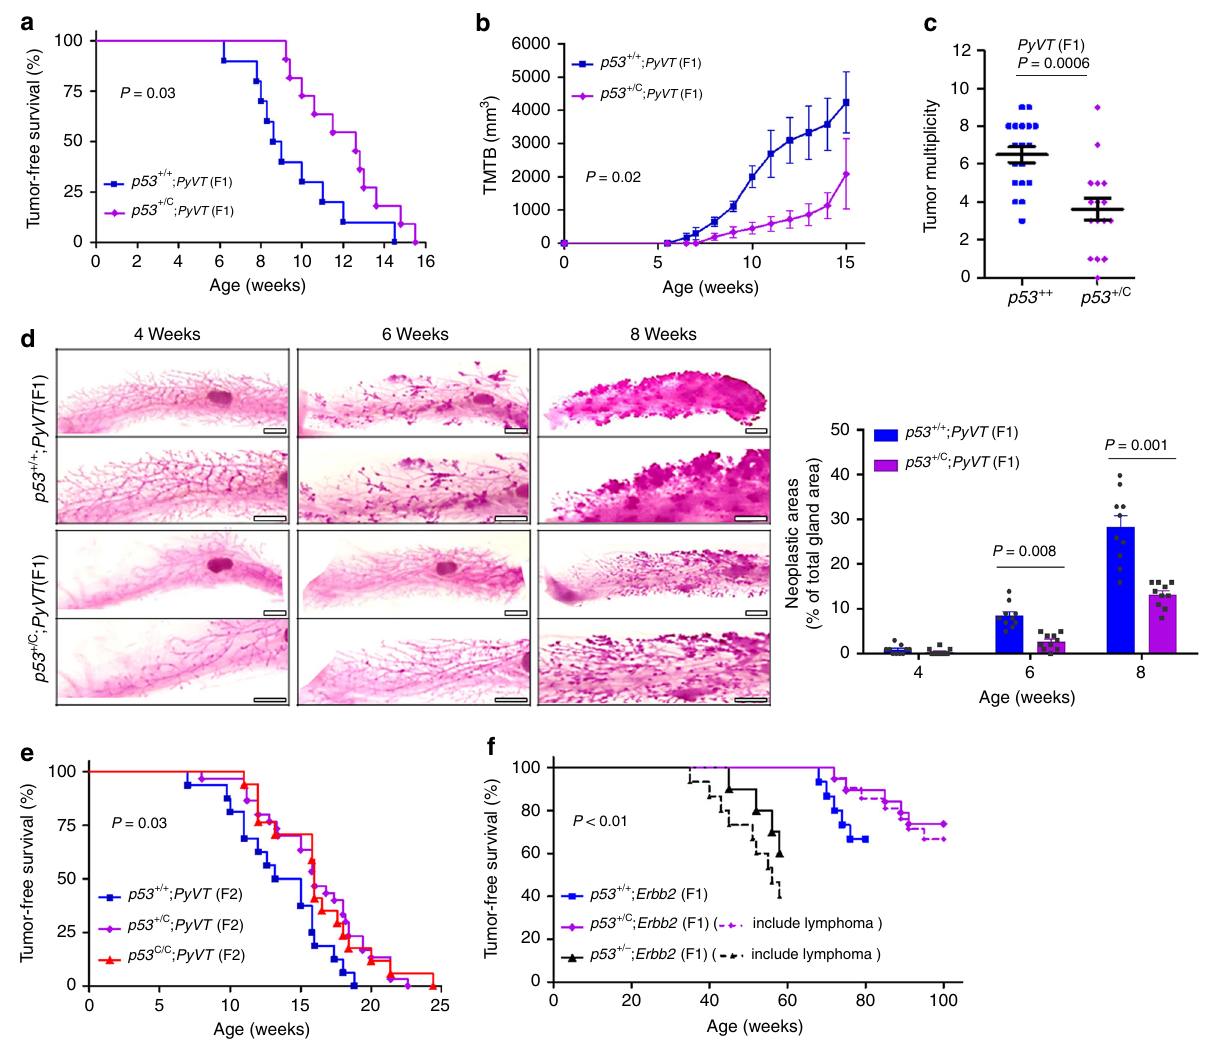
Fig. 2 p53 C delays either PyVT - or Errb2 -driven mammary tumorigenesis in mice. a Tumor-free survival of F1 female offspring of p53 + /C mice crossed with PyVT -overexpressing mice (FVB/N-Tg(MMTV-PyVT)634Mul/J). n = 10 for p53 + / + ; PyVT and n = 11 for p53 + /C ; PyVT ; P = 0.03 (log-rank test). b Tumor volume in F1 female p53 + / + ; PyVT and p53 + /C ; PyVT mice at indicated ages. TMTB total measured tumor burden. P = 0.02 (Mann – Whitney U test). c Tumor multiplicity in F1 females at 15 weeks. The data were presented as mean ± s.e.m., error bars depict s.e.m.; P = 0.0006 (Mann – Whitney U test). d Whole-mount carmine red stain of the mammary glands from F1 females at indicated ages. n = 5 mice per group. Scale bar, 2 mm. On the right was the quanti fi cation of neoplastic/hyperplastic areas as a percentage of the total gland areas as shown (left) using image analysis. The data were presented as mean + s.e.m., error bars depict s.e.m. ( n = 10 mammary gland from fi ve mice per group) and analyzed with two-sided Student ’ s t test. e Tumor-free survival of F2 female offspring (obtained by crossing F1 p53 + /C ; PyVT with F1 p53 + /C mice). P = 0.03 (log-rank test). f Mammary tumor-free survival and tumor-free survival of F1 female offspring from Erbb2 mice interbred with p53 + /C mice. As p53 + /C and p53 + / − mice may develop lymphoma, dashed lines indicated tumor-free survival ( P = 0.006, log-rank test) and solid lines indicated mammary tumor-free survival ( P < 0.001, log-rank test), i.e., dashed lines included 2 of the 21 p53 + /C ; Erbb2 mice and 5 of the 15 p53 + / − ; Erbb2 mice that developed lymphomas. p53 + / − ; Erbb2 mice, as a control, were obtained